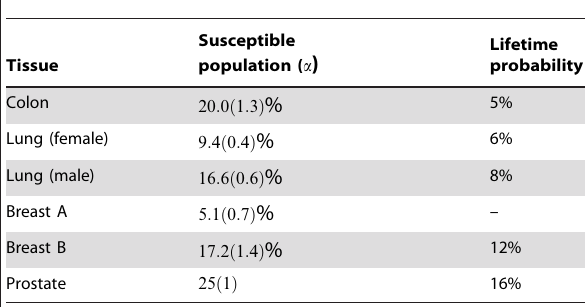
Table 1. This table shows an estimate of the fraction of the population susceptible to each form of carcinoma, as measured by the parameter a